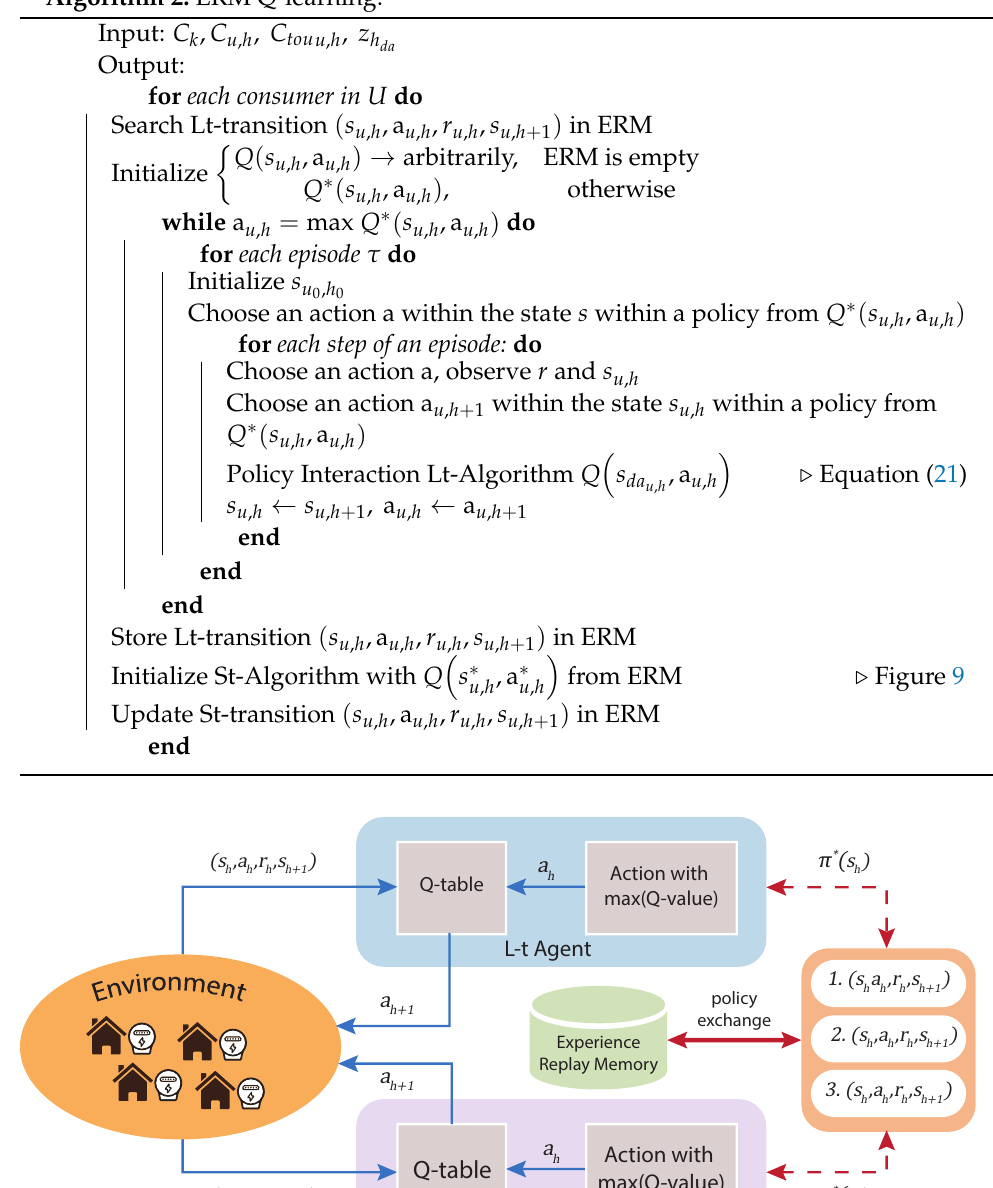
Algorithm 2: ERM Q-learning.